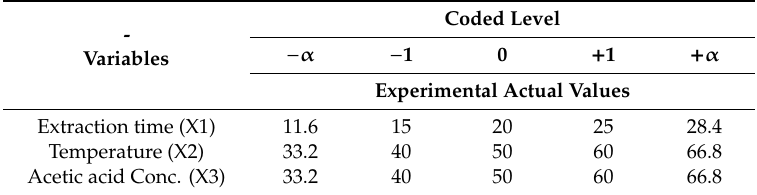
Table 1. Coded and actual levels of independent variables used in response surface